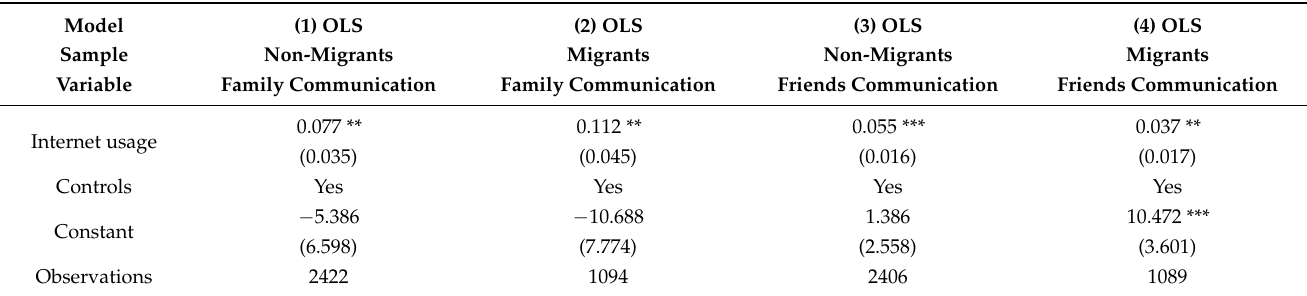
Table 15. Heterogeneity analysis in terms of